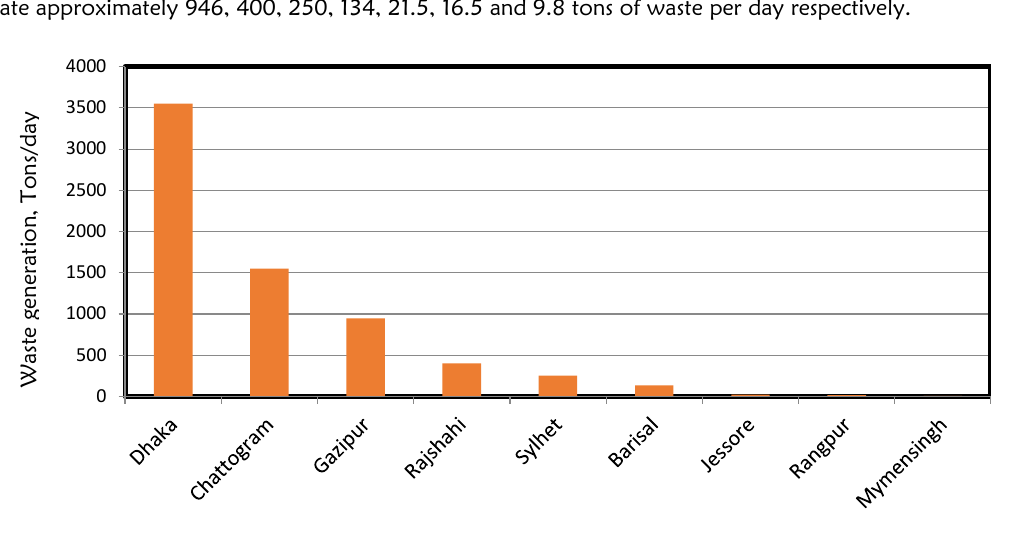
Figure7: Waste generation in major cities of